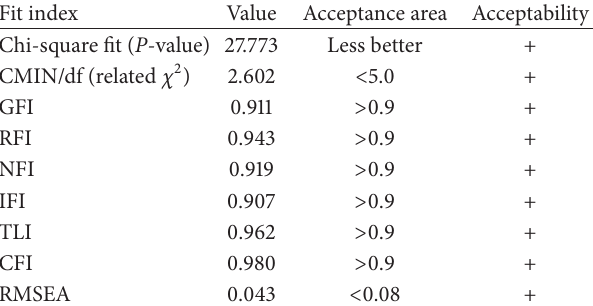
Table 5: Factor loading for physical